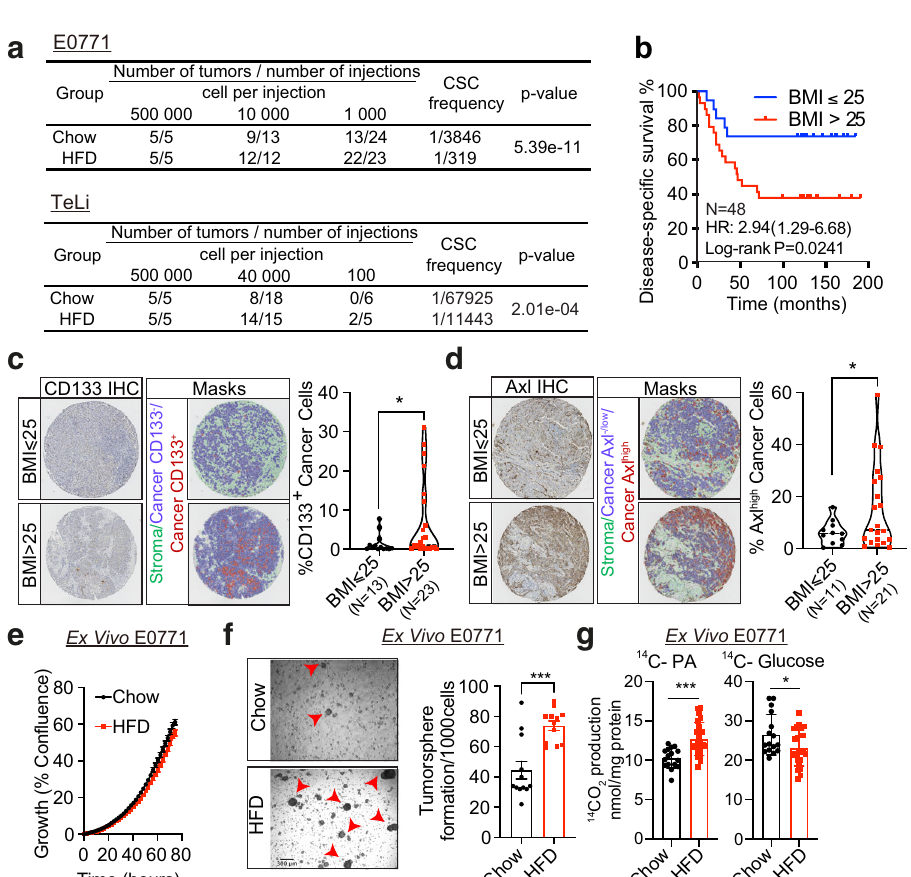
Fig. 1 Obesity is associated with increased frequency of stem cell-like cancer cells in PM/ER − /PR − breast cancer patients and mouse models of breast cancer. a Tumor incidence following orthotopic implantation of cancer cells into the mammary fat pads of chow- and HFD-fed mice. b Kaplan – Meier curves show disease-speci fi c survival for PM/ER − /PR − patients ( n = 48) with high (red) or low (blue) BMI. Log-rank (Mantel – Cox) P value is denoted for difference in disease-speci fi c survival. c , d Representative tissue microarray and QuPath analysis mask pictures of CD133 ( c ) and Axl ( d ) staining in high (BMI > 25, n = 23 for CD133; n = 21 for Axl) or low (BMI ≤ 25, n = 13 for CD133; n = 11 for Axl) BMI PM/ER − /PR − patients ’ tumor samples, stroma is marked in green, CD133 − or Axl − /low cancer cells are marked in blue and positive staining cancer cells are marked in red (for c , P = 0.0245; d , P = 0.023). e Time-dependent proliferation assay of ex vivo E0771 cells isolated from chow or HFD-fed mice. For each time point, data are represented as mean ± SEM of four tumor samples (eight replicates per tumor sample were measured) from each group. f Tumorsphere formation assay of E0771 ex vivo cells isolated from chow diet or HFD-fed mice. Representative images of day-5 tumorspheres formation of E0771 ex vivo cells and red arrowheads mark the identi fi ed tumorspheres. Quanti fi cation of day-5 tumorspheres is represented as mean ± SEM of four tumor samples from each group and three replicates were measured for each sample, P = 0.0002. g Fatty acid and glucose oxidation on E0771 ex vivo cells isolated from two chow diet-fed mice and three HFD-fed mice. The oxidation data are normalized to cell protein content. For each sample, 8 replicates are measured and data are represented as mean ± SEM of all replicates from each group. Fatty acid oxidation P = 0.0002, Glucose oxidation P = 0.0365. For c , d , unpaired, two-tailed Welch ’ s t -test was used for statistical testing. For f , g , statistical signi fi cance determined with unpaired, two-tailed Student ’ s t -test (* P value <0.05; *** P value <0.001). Source data are provided as a Source data fi